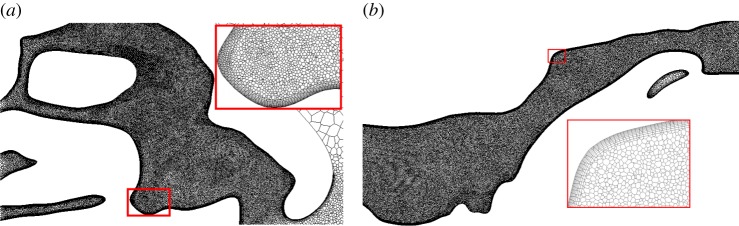
Details of the airway mesh on planes in the nose (a) and oropharyx, hypopharynx and larynx (b). (Online version in colour.)